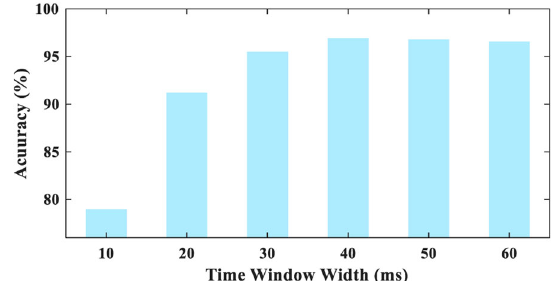
Fig. 9 Performance of ensemble ELM classifier with different time window